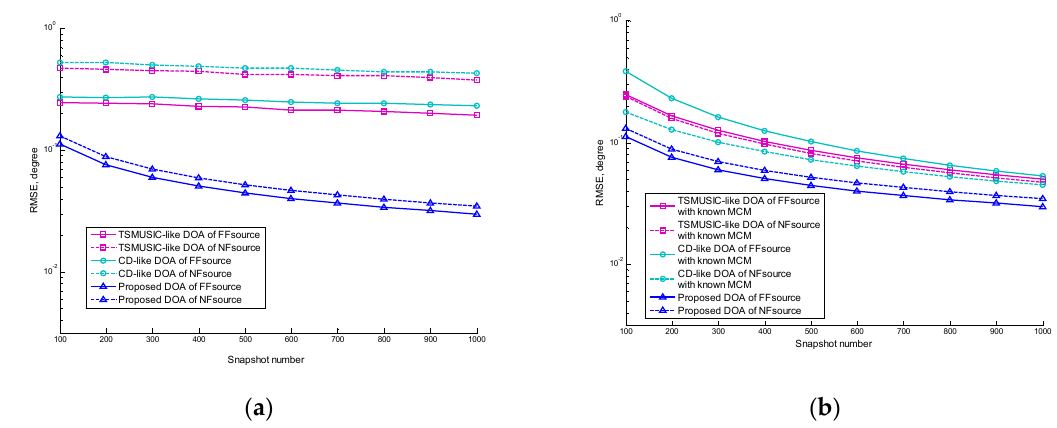
Figure 5. ( a ) Root mean square error (RMSEs) of the direction of arrival (DOA) estimates versus snapshot number; ( b ) RMSEs of the DOA estimates versus snapshot number with known mutual coupling matrix (MCM).